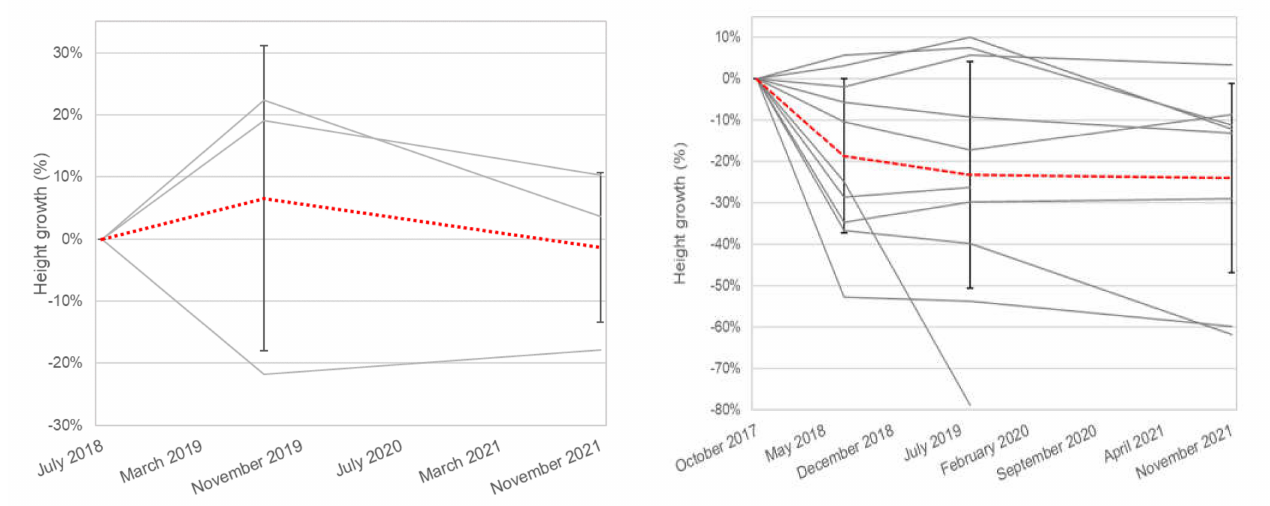
Figure 7. Height growth (expressed in percentage) of C. rubrum transplants using the grid method under crevices ( left ) and on rock ( right ) from the beginning of the experiment until November 2021 with the average (red line) and standard deviations. A growth stopping translates to a transplant